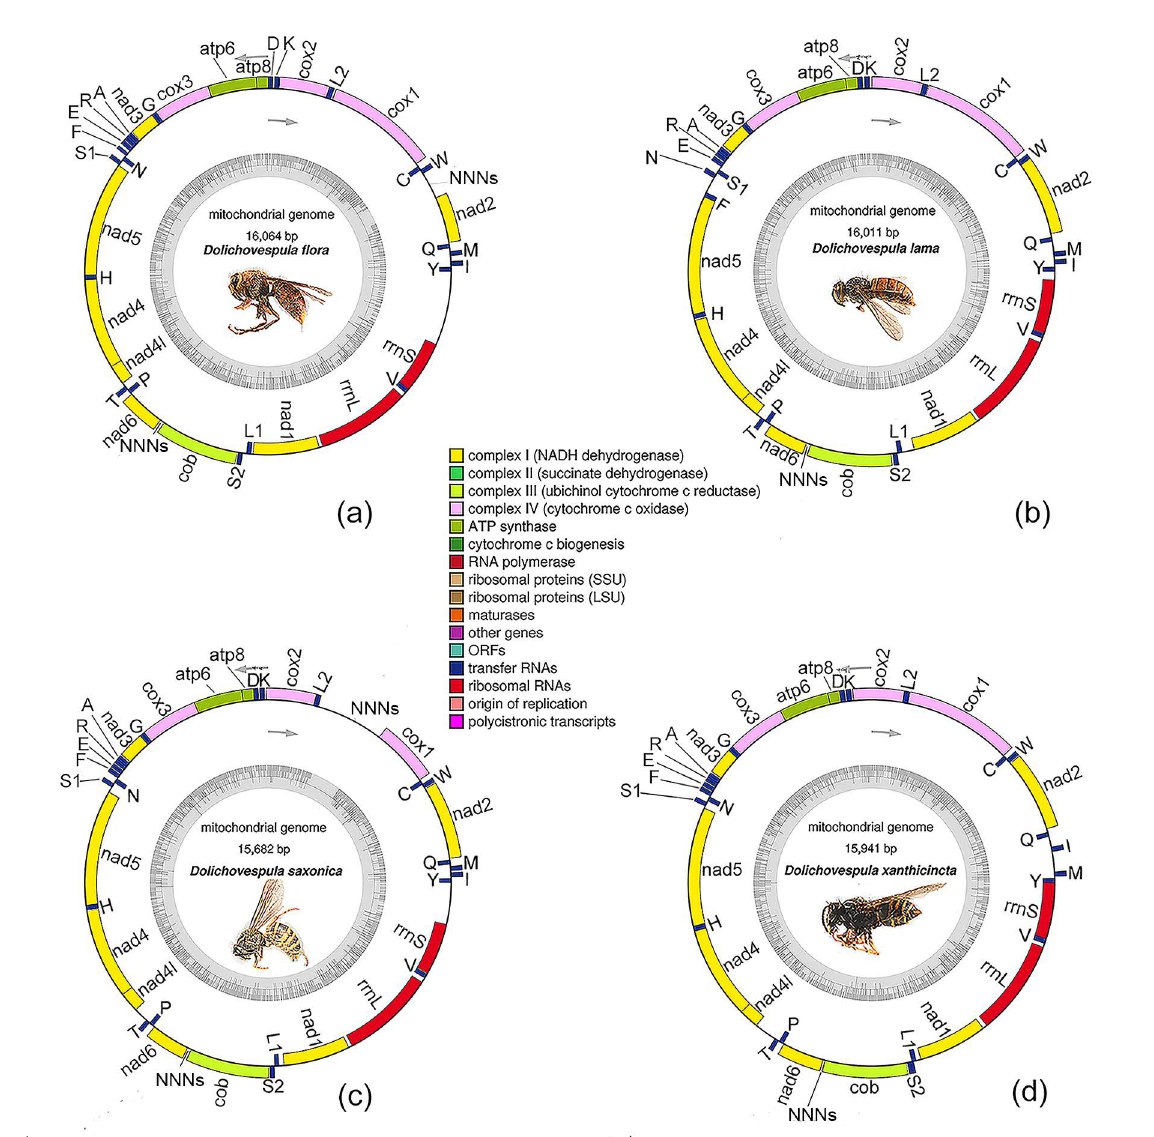
Figure 1. The mitochondrial genomic maps of Dolichovespula spp. ( a ) Dolichovespula flora ; ( b ) D. lama ; ( c ) D. saxonica ; ( d ) D. xanthicincta . Note: The location of the genes on the direct strand is indicated by colored blocks outside each ring, while the location of the genes on the reverse strand is indicated by colored blocks inside each ring. The NNNs represent the estimated